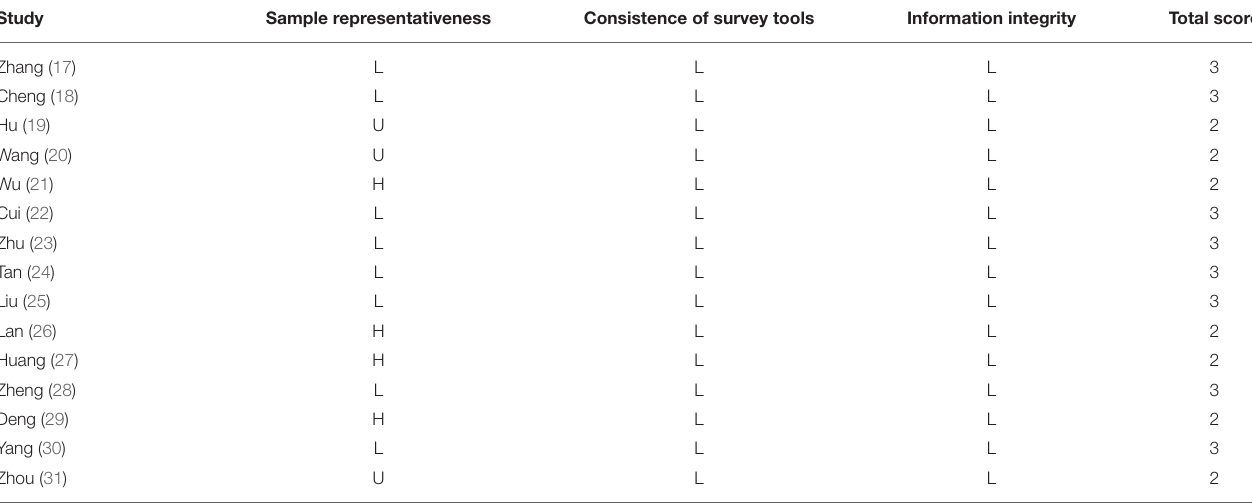
TABLE 2 | Risk of bias assessment. Study